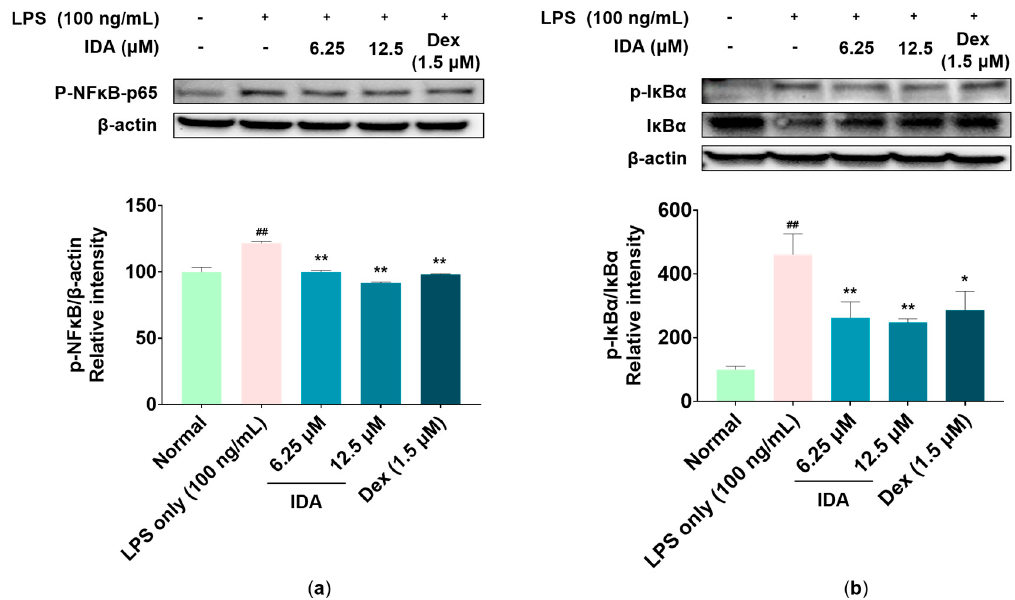
Figure 7. Effect of isodorsmanin A (IDA) on the protein levels of ( a ) phosphorylated (p)-nuclear factor kappa-light-chain-enhancer of activated B cells (NF- κ B)-p65, ( b ) nuclear factor of kappa light polypeptide gene enhancer in B-cells’ inhibitor, alpha (I κ B- α ), and p-I κ B- α in macrophages. Cells were pretreated with IDA (6.25 or 12.5 μ M) for 3 h and then stimulated with 100 ng/mL of LPS for another 2 h. Western blot results are from duplicate independent experiments. The results in the graphs are presented as the mean ± standard error from triplicate measurements. * p < 0.05 and ** p < 0.01 indicate significant differences vs. the LPS-only group. ## p < 0.01 indicates significant differ- ence vs. Normal group. Dexamethasone (Dex); positive control.